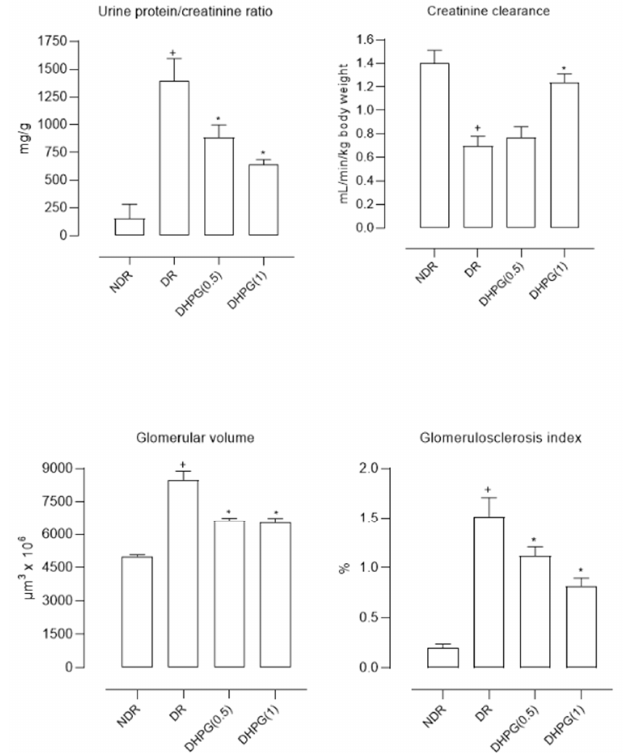
Figure 1. Mean values (mean ± standard deviation) of the urine protein/creatinine ratio, creatinine clearance, glomerular volume, and glomerulosclerosis index in control non-diabetic rats (NDR), control diabetic rats (DR), and DR treated with 3’,4’-dihydroxyphenylglycol (DHPG) 0.5 (DHPG (0.5)) or 1 (DHPG (1)) mg/kg/day p.o. + p < 0.05 with respect to NDR. * p < 0.05 with respect to DR. Nutrients 2023 , 15 , x FOR PEER REVIEW The glomerular volume was significantly higher in diabetic animals compared to healthy controls (69.4% higher) (Figures 1 and 2), reducing by 22.7% and 22.6% with DHPG 0.5 and 1 mg/kg/day, respectively. This behavior profile was observed with the glomerulosclerosis index, which was significantly higher in diabetic control animals (Fig ‐ ures 1 and 2), decreasing by 26.3% and 46.1% with DHPG 0.5 and 1 mg/kg/day, respec ‐ tively.